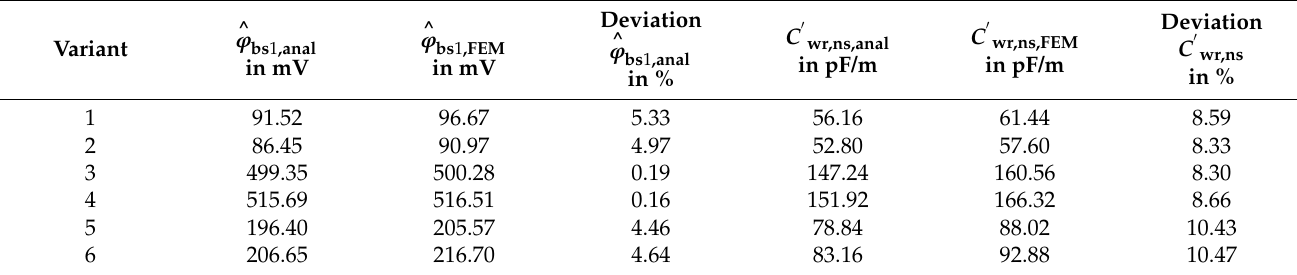
Table 3. Comparison of the analytically calculated potential amplitudes at the transition slot—air gap and the length-related slot portions of the winding-to-rotor capacitance analytically calculated in the air gap model, according to Reference [11], with the FEM results.